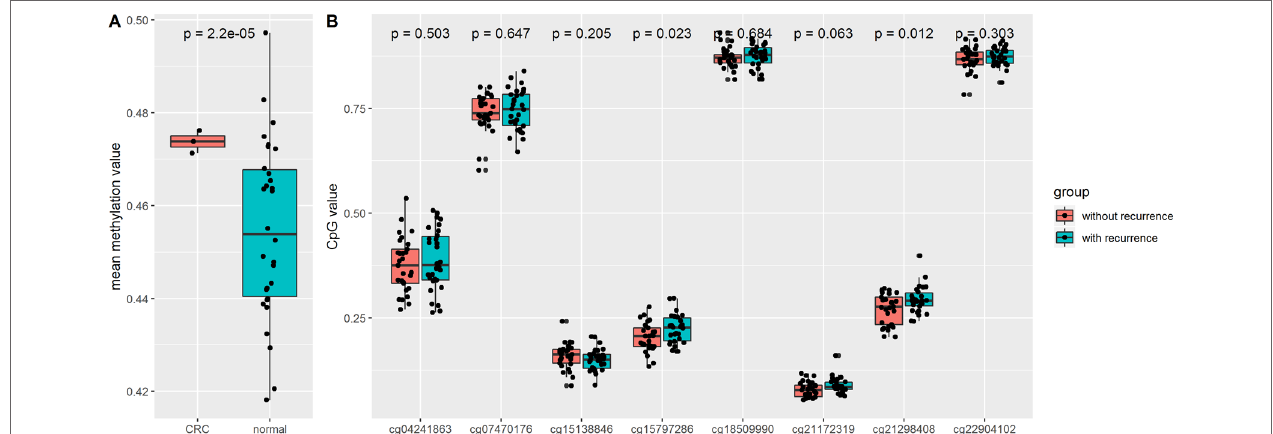
FIGURe 5 | (A) Comparison of mean CpG value of N - acetyltransferase 1 ( NAT1 ) in colorectal adenomas and normal tissues; (B) Comparison of methylation of CpG sites in colorectal adenomas and normal tissues.